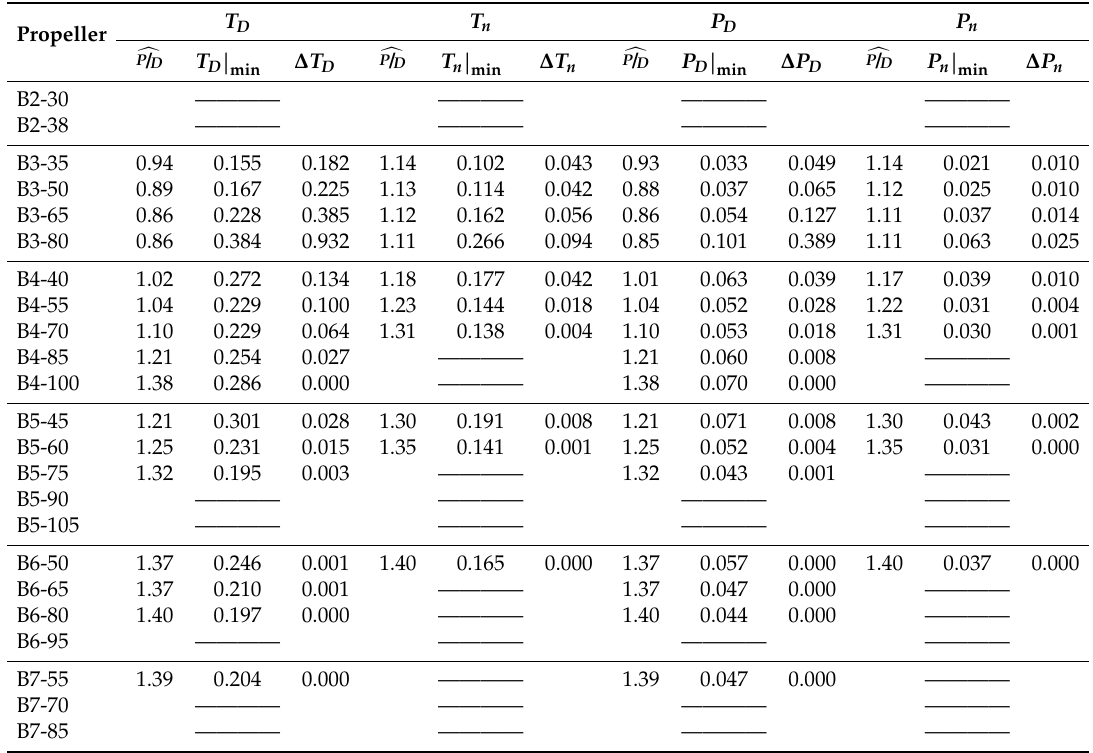
Table 2. Main characteristics of all overlaps found in the recreated Danckwardt diagrams. (For symbols and definitions, see Section 3.2 and Figure